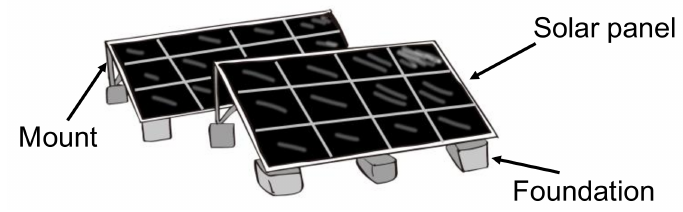
Figure 6. PV system elements prone to damage by